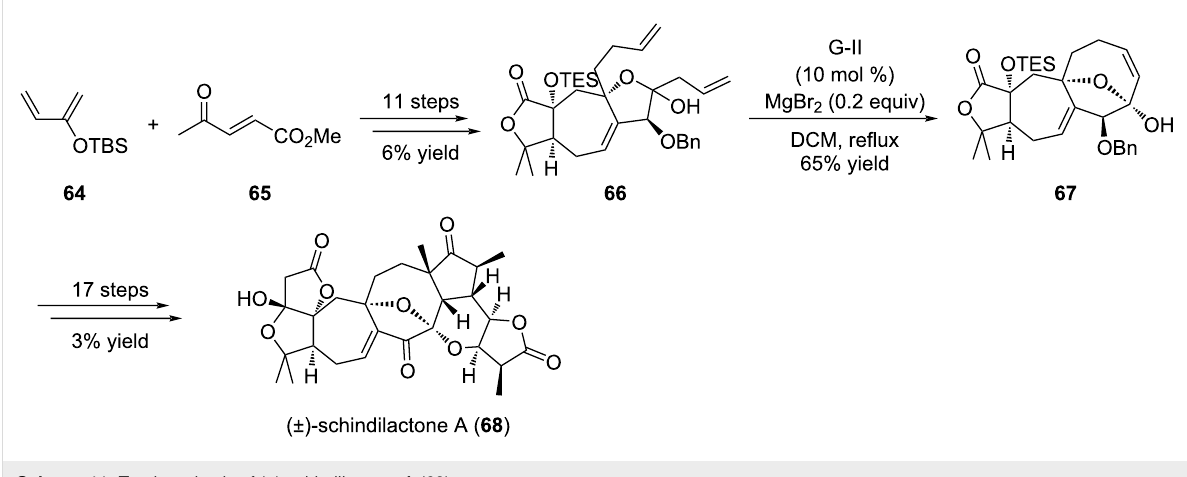
Scheme 11: Total synthesis of (±)-schindilactone A ( 68 ).